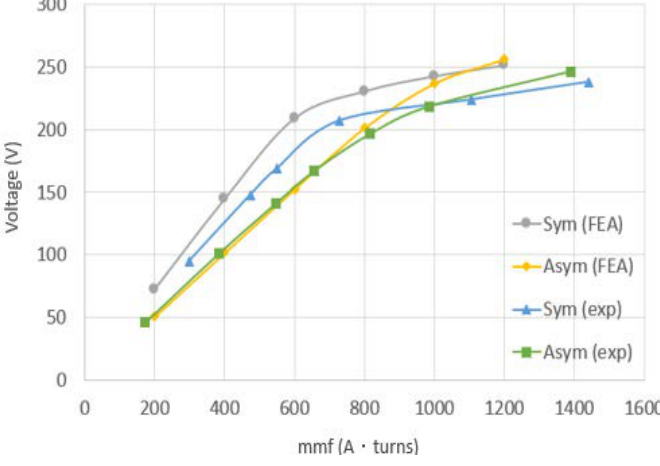
Figure 11. Comparison of the constant-speed variable-excitation test.